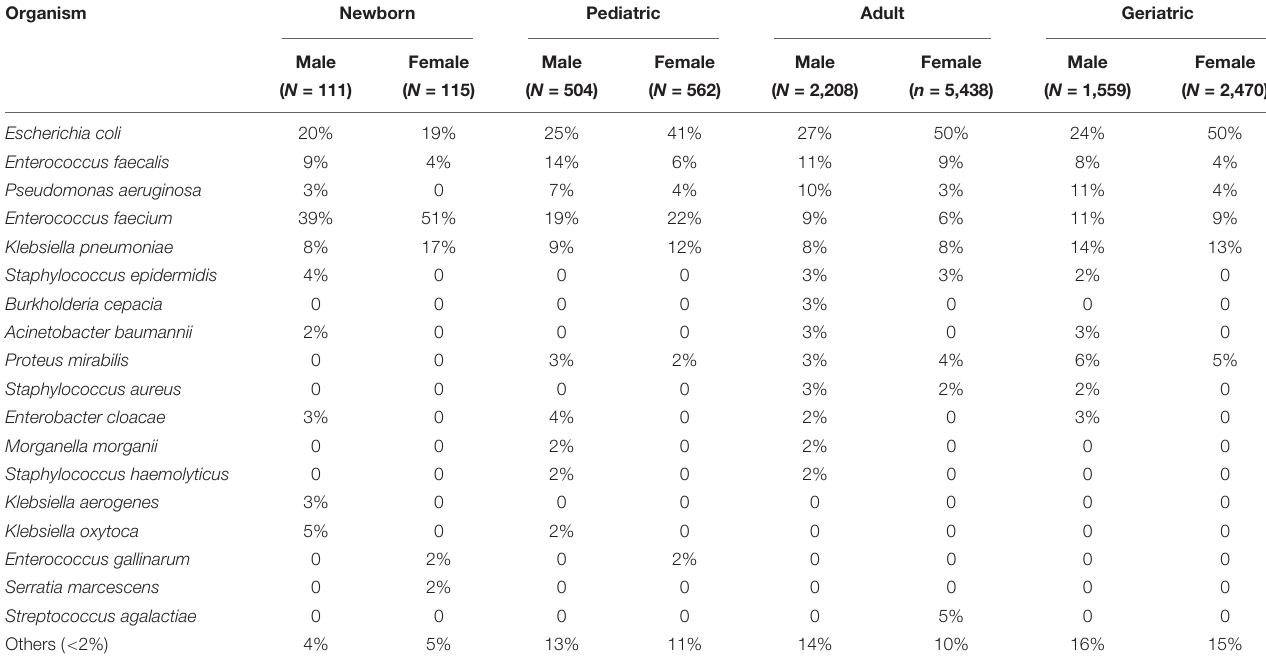
TABLE 1 | Comparison of etiological profile between male and female among different age